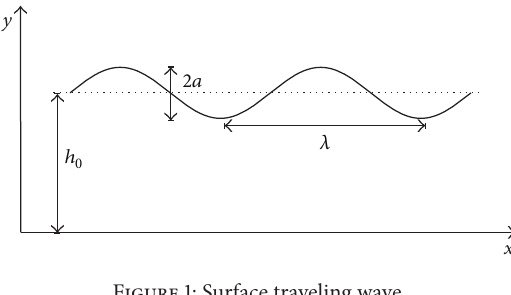
Figure 1: Surface traveling